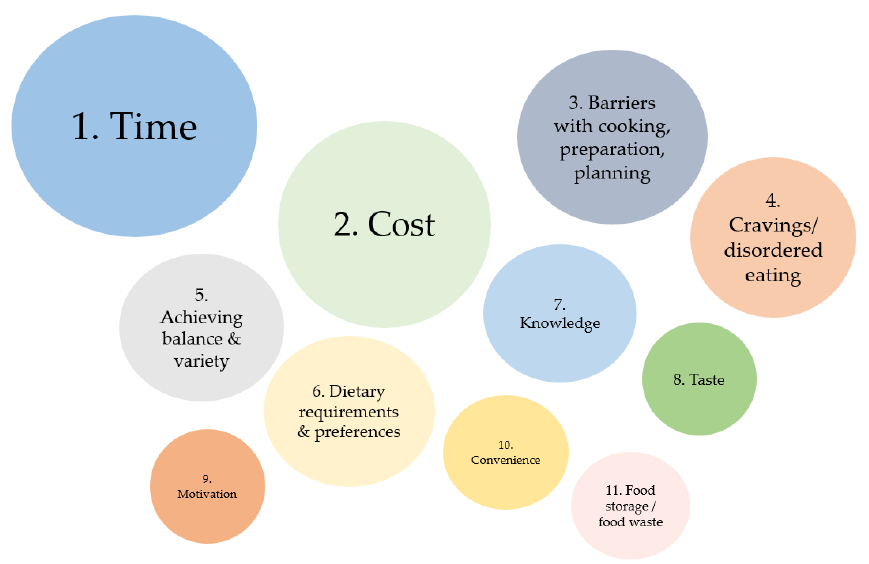
Figure 1. Summary of themes identified as challenges to healthy eating among young adults who use the ‘No Money No Time’ website. Table 3. Summary of challenges and resources used in relation to healthy eating among young adults with low diet quality who use the ‘No Money No Time’ website.